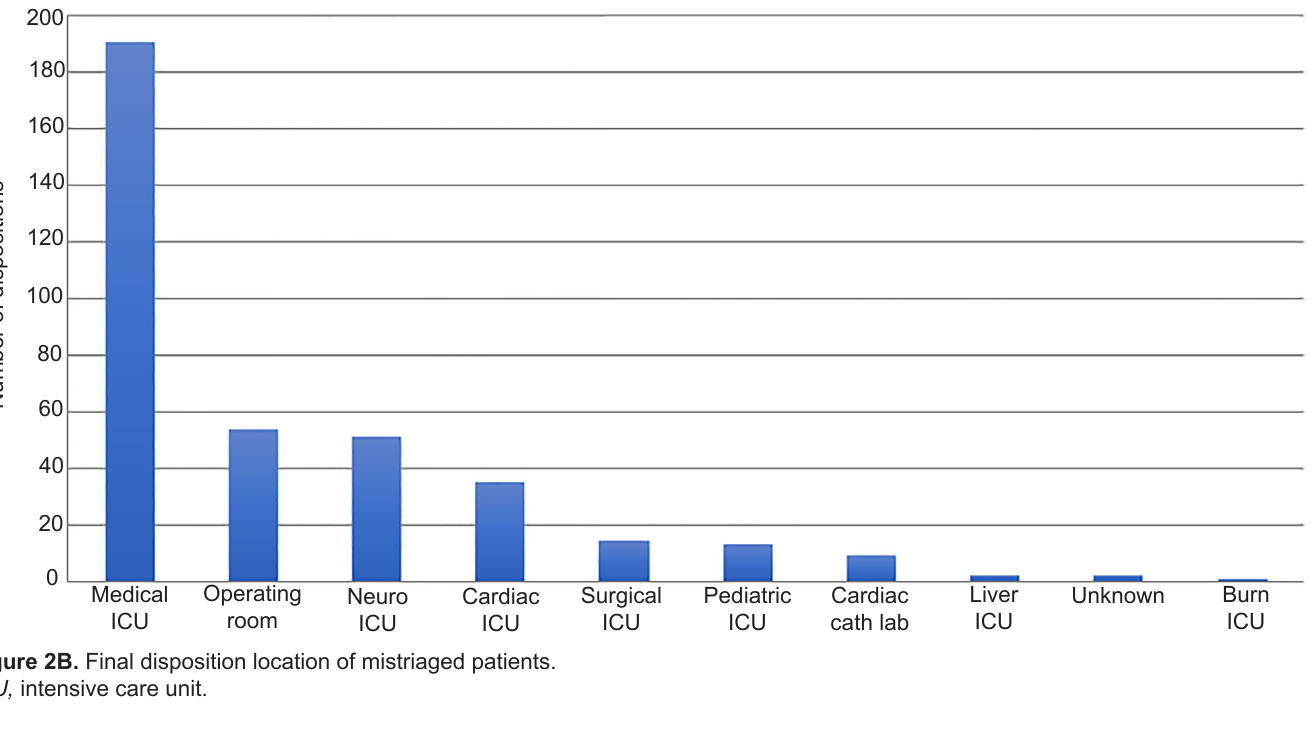
Figure 2B. Final disposition location of mistriaged patients. ICU, intensive care unit.